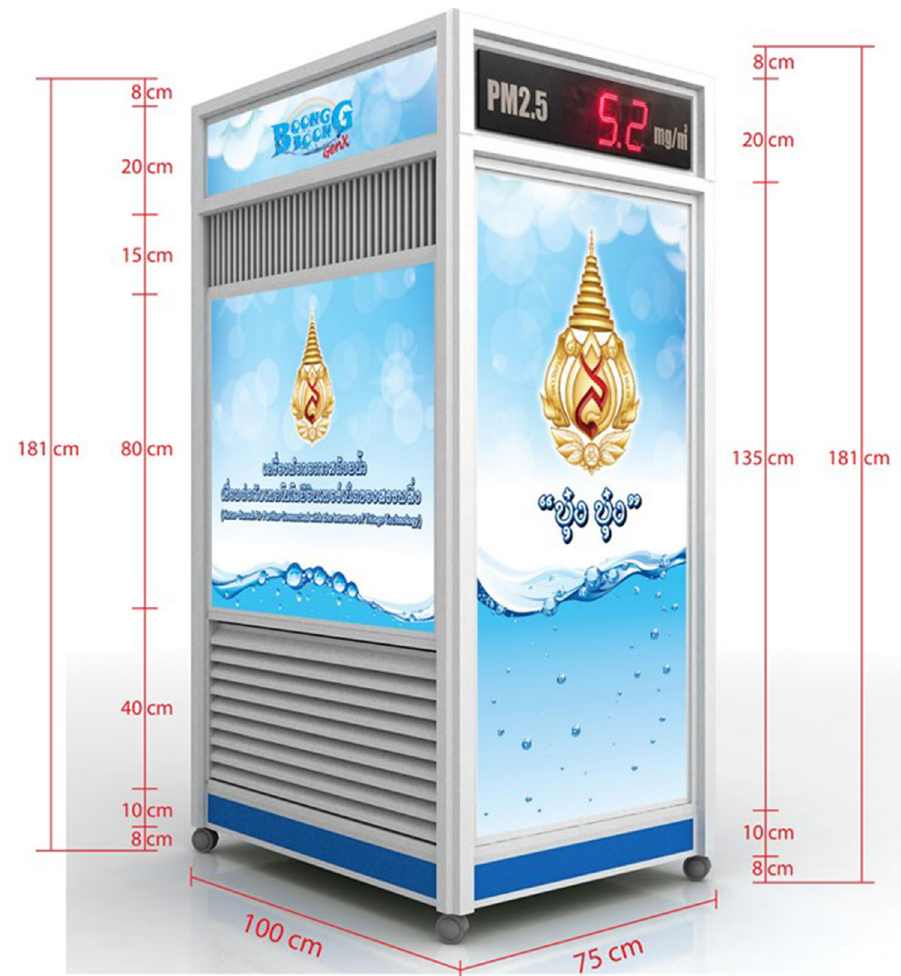
Fig. 1 Outer dimensions of water-based air purifier. Bot- tom grills serve as an air inlet, whereas top grills represent as an air